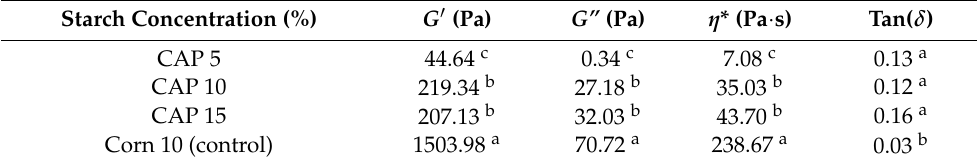
Table 7. Dynamic viscoelastic properties of Ceiba aesculifolia subsp. parvifolia tuber starch. Starch Concentration (%) G (cid:48) (Pa) G” (Pa) η * (Pa · s) Tan( δ ) CAP 5 44.64 c 0.34 c 7.08 c 0.13 a CAP 10 219.34 b 27.18 b 35.03 b 0.12 a CAP 15 207.13 b 32.03 b 43.70 b 0.16 a Corn 10 (control) 1503.98 a 70.72 a 238.67 a 0.03 b